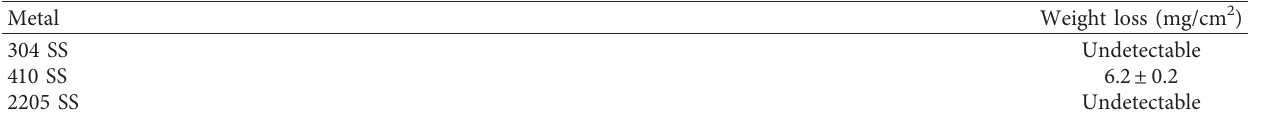
Table 3: Weight loss after 7-day incubation (standard deviations from replicate coupons in three SRB bottles).